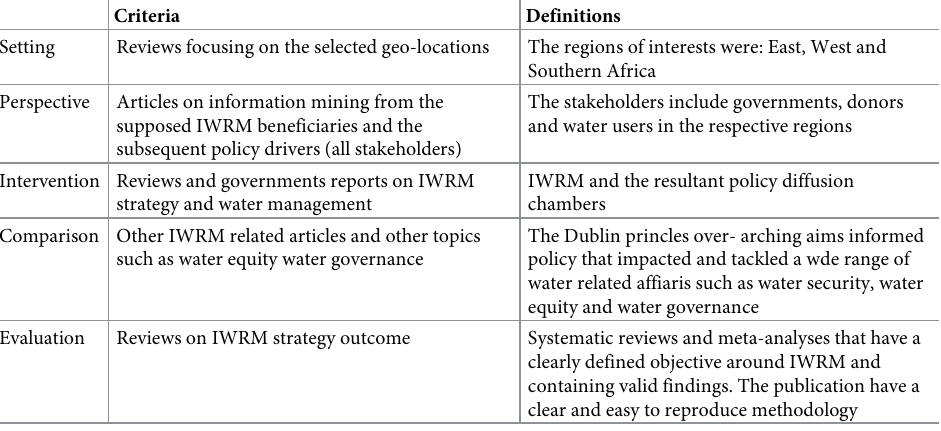
Table 1. The Adapted SPICE structure for formulating the inclusion and exclusion criteria.